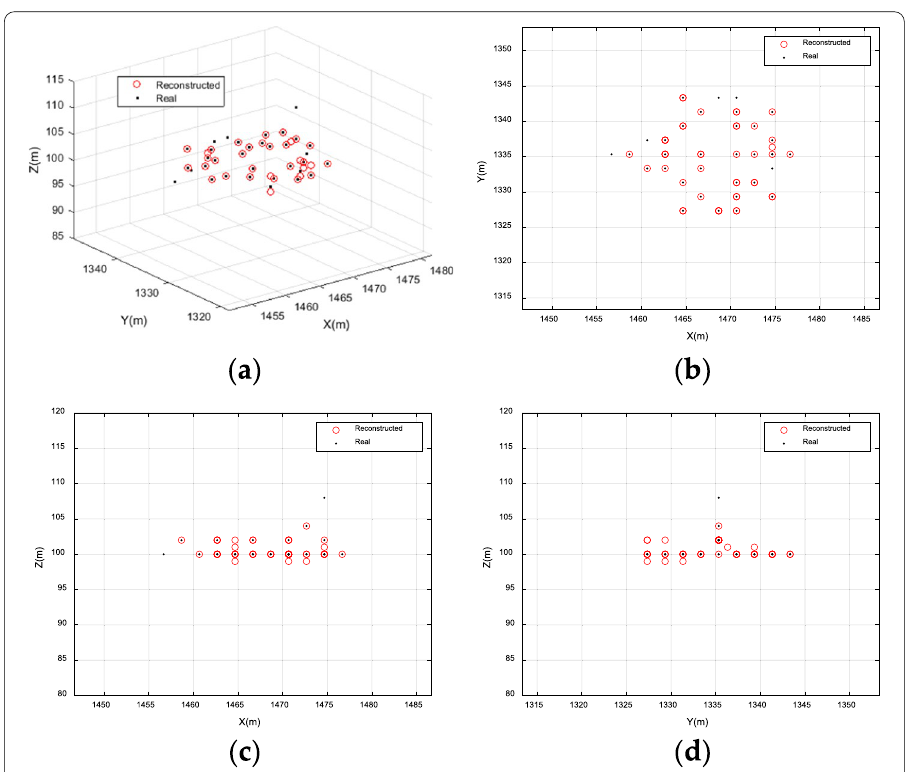
Fig. 12 The real and reconstructed 3-D target image for target 6. a 3-D view. b Vertical view. c Side view. d Front view. The red circles and the black dots represent the reconstructed scatters and the real scatters of the target,